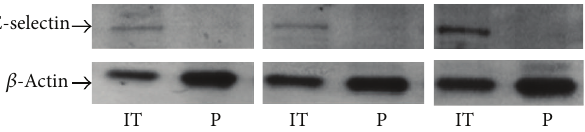
Figure 3: Western blotting exhibited lower E-selectin expression in nasal polyps (P) than in the inferior turbinate (IT) of chronic rhinosinusitis patients ( 𝑛 = 8